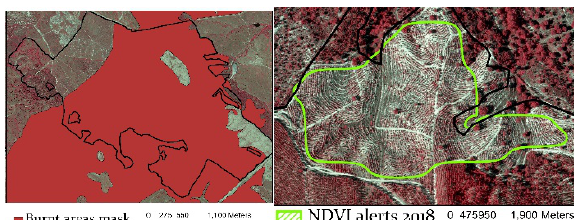
Figure 4. COS2018 polygon overlaid with the burnt mask (left) and clear-cuts in Eucalyptus plantation (right)